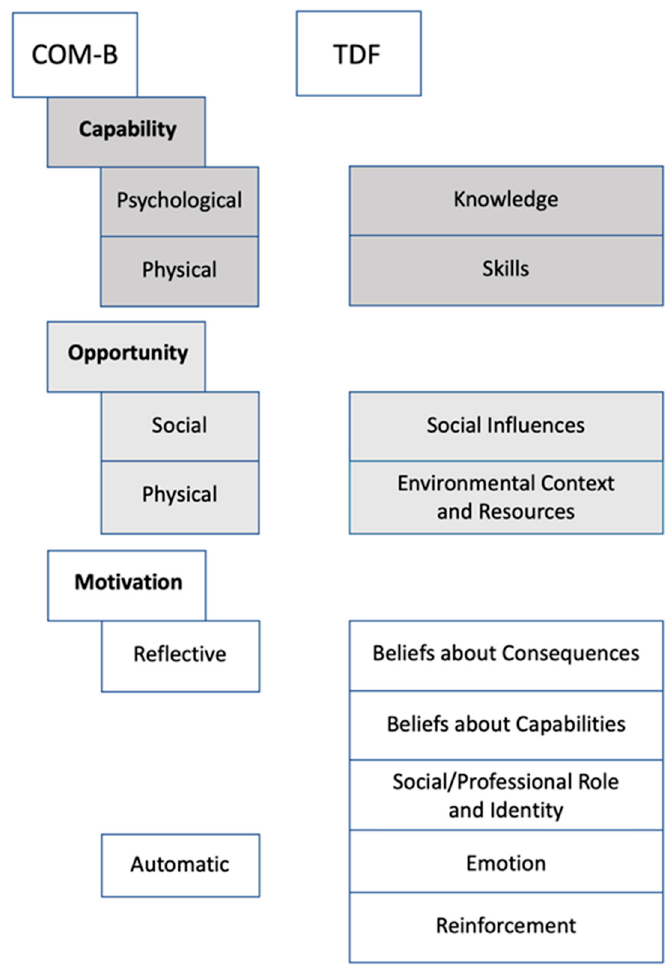
Figure 1. Relation between the TDF and COM-B within the present study.